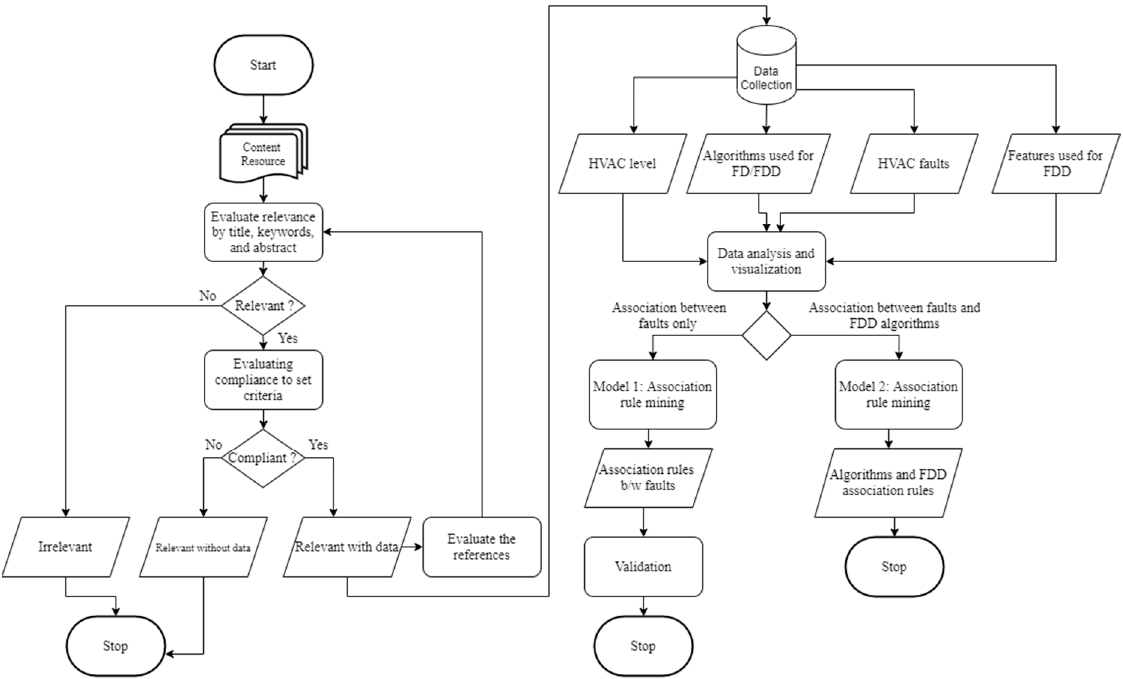
Figure 3. High-level methodology used for data collection, analysis, and knowledge discovery.